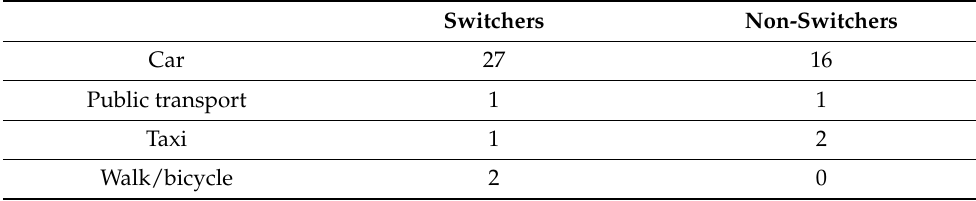
Table 3. Mode of transport used prior to invitation to